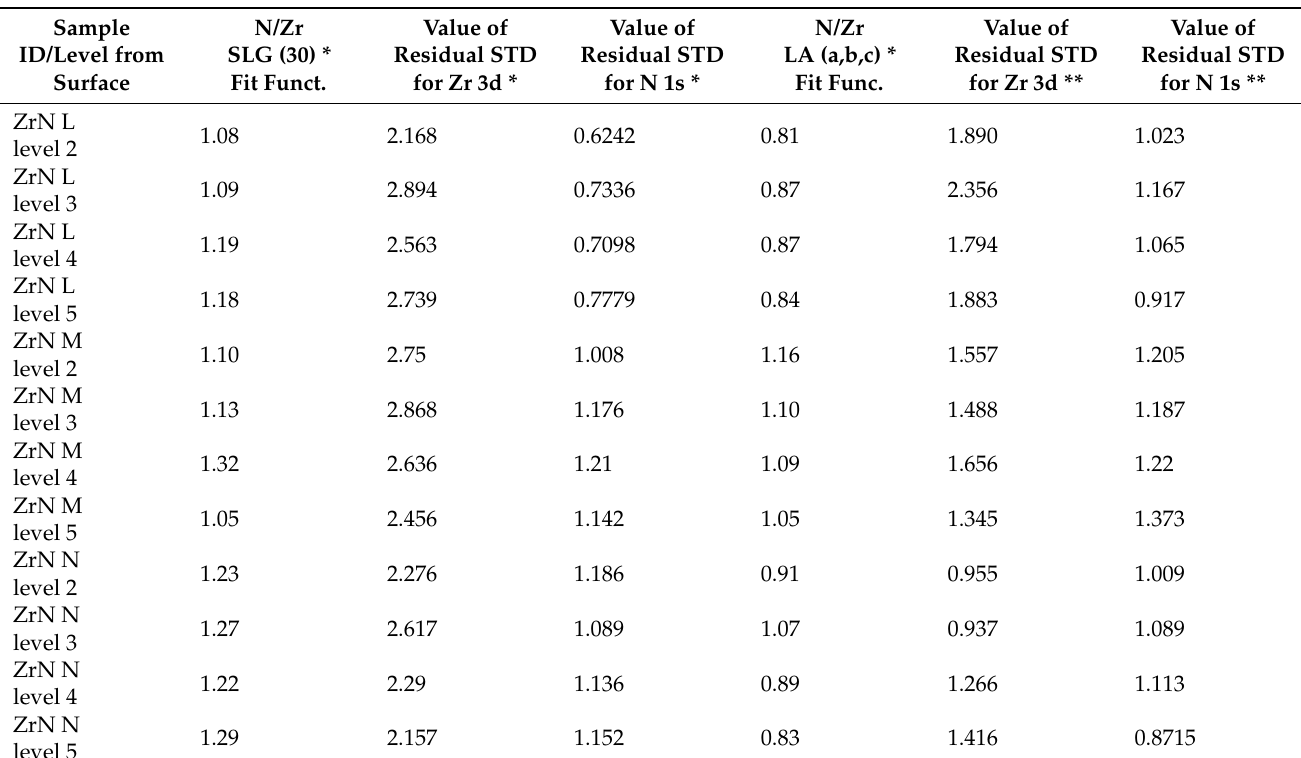
Table 4. ZrN samples quantitative